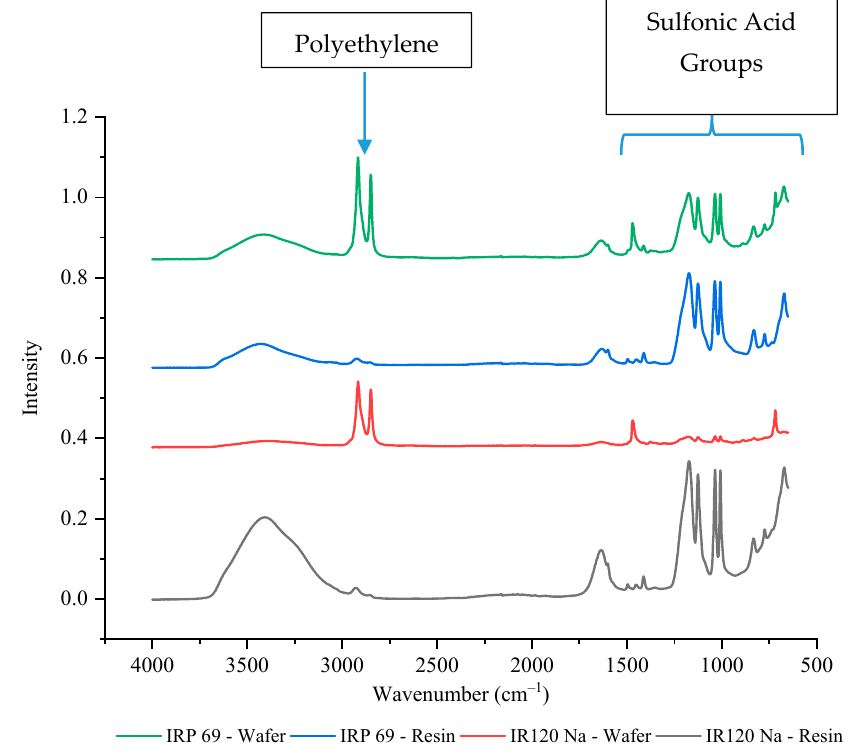
Figure 5. The FTIR-ATR spectrum of strong cation exchange resins and wafers including these resins. To verify that this was not the result of a single batch issue or due to analysis place- ment, another batch of IR 120 Na + wafer was made and multiple locations were tested using FTIR-ATR. Figure 6 shows that the second batch of IR 120 Na + wafer also had lower intensities of sulfonic acid functional groups compared to the IR 120 Na + resin, especially